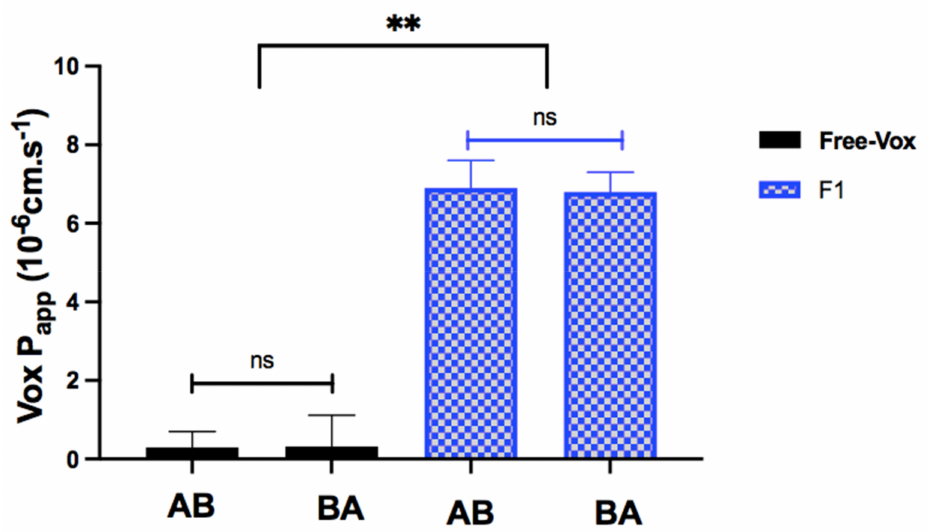
Figure 9. The apparent permeability (P app ) values of Vox across the Caco-2 cell monolayer-free drug and F1 after 2 h of the AB and BA transport studies. Each value is the mean of three separate determinations. ns p > 0.01, ** p <